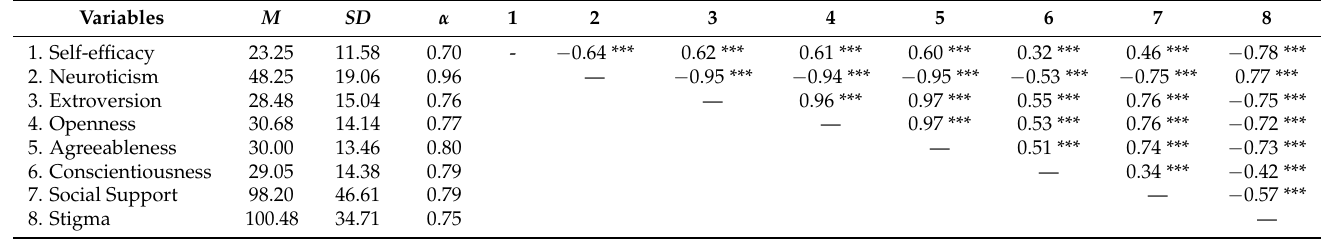
Table 1. Descriptive Statistics, Alpha Reliability and Pearson Correlation of Variables (N =